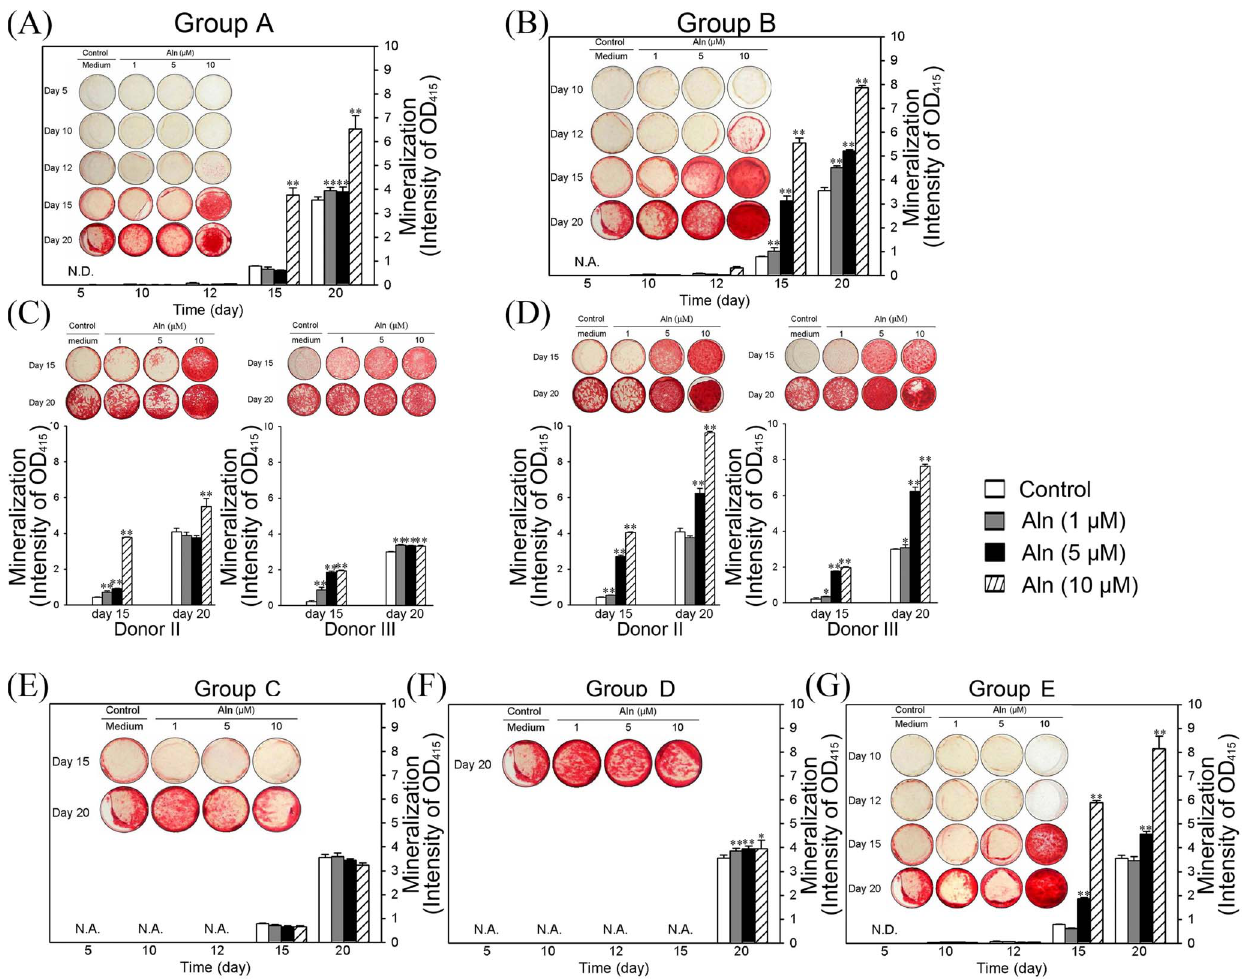
Figure 2. The mineralization effects of Aln on hBMSCs after different treatment strategies. Undifferentiated hBMSCs were treated with 1, 5 or 10 m M Aln during the culture time indicated in Figure 1. The mineralization levels were measured by ARS staining (shown as photographs), which was further quantified (shown as bar). The mineralization of group A (A) and group B (B) of donor I were measured at day 5, 10, 12, 15 and 20. The mineralization of donor II and donor III in group A (C) and group B (D) were measured at days 15 and 20. The mineralization of groups C (E), D (F) and E (G) of donor I were also determined using ARS staining (photographs) and quantified (bar). N.A: not available; N.D: not detectable; * p , 0.05; ** p , 0.01